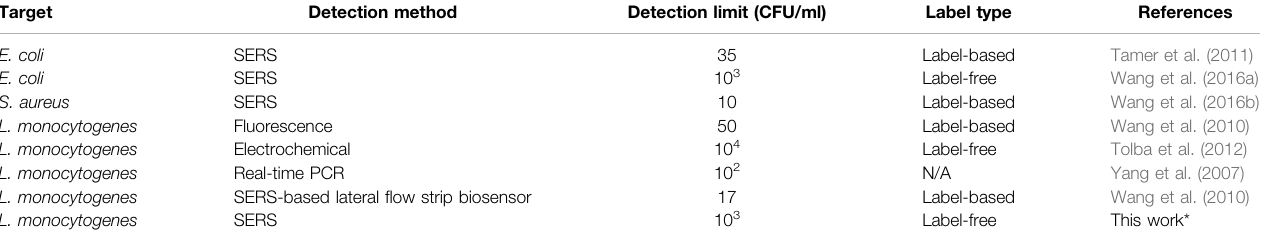
TABLE 2 | Previously reported methods for bacteria detection using label-based and label-free probes. *This work is inserted for immediate comparison.